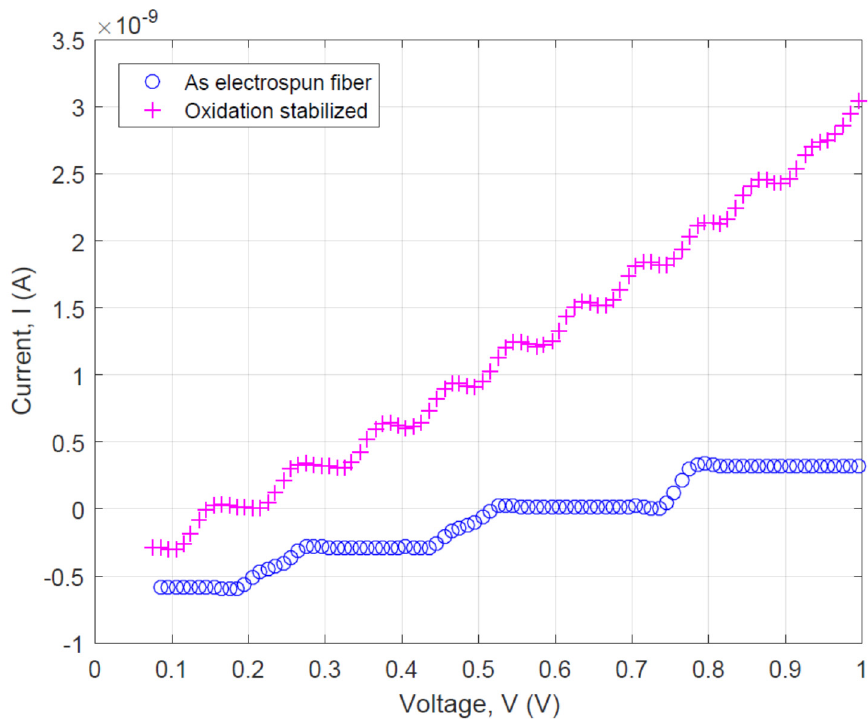
Figure 3. I–V plots for the as-spun polymer fiber (at 20 °C) and the oxidized fiber (at 250